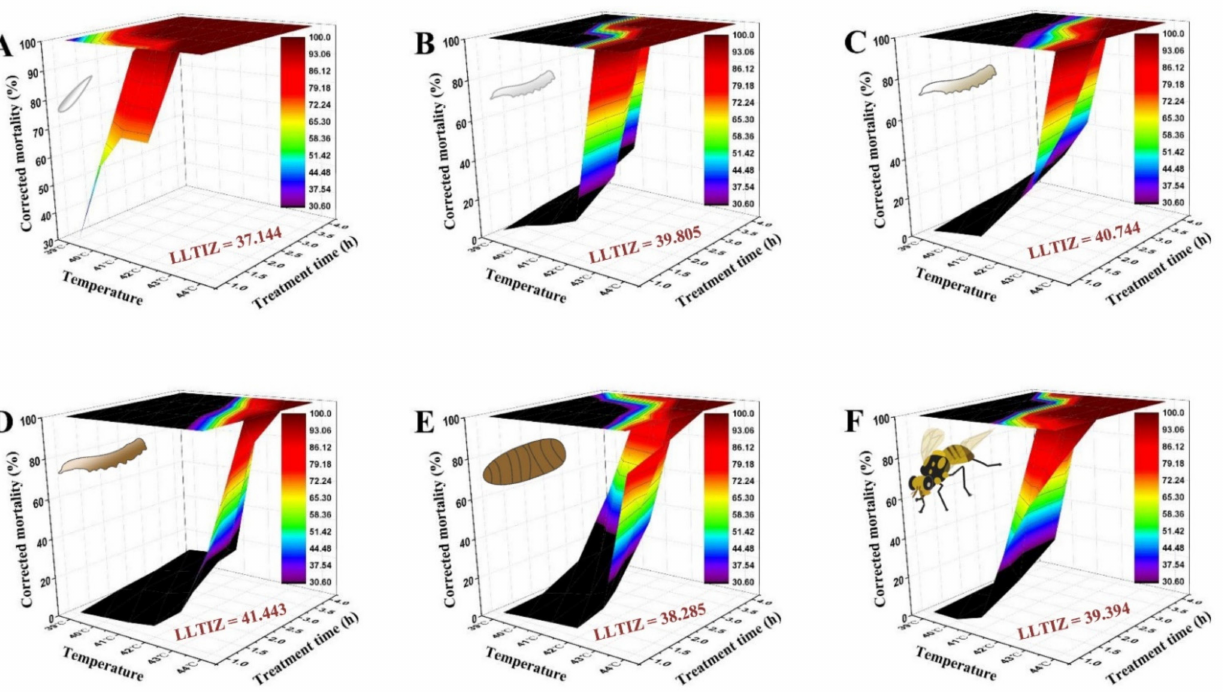
Figure 4. Three-dimensional surface models describing the relationship between exposure time, high temperature, and corrected mortality of different developmental stages of Bactrocera tau . The lower limit of the thermal injury zone (LLTIZ) corresponds to the temperature above which mortality occurs under continuous heat stress. ( A ) Eggs (LLTIZ = 37.144 ◦ C), ( B ) 1st instar larvae (LLTIZ = 39.805 ◦ C), ( C ) 2nd instar larvae (LLTIZ = 40.744 ◦ C), ( D ) 3rd instar larvae (LLTIZ = 41.443 ◦ C), ( E ) 1-day-old pupae (LLTIZ = 38.285 ◦ C), and ( F ) 3-day-old adults (LLTIZ = 39.394 ◦